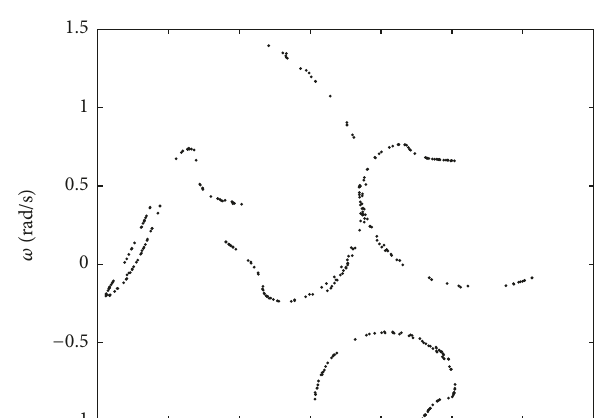
Figure 5: Spectrum diagram.